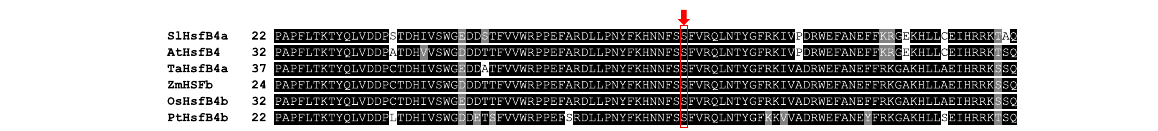
Fig. 4 BoxShade presentation of the highly conserved HSF-DNA binding domains of SolycHsfB4a of various plant species. The serine (marked in red) is replaced by cysteine in the brt-2 line. At, Arabidopsis thaliana ; Ta, Triticum aestivum ; Zm, Zea mays ; Os, Oryza sativa ; Pt, Populus